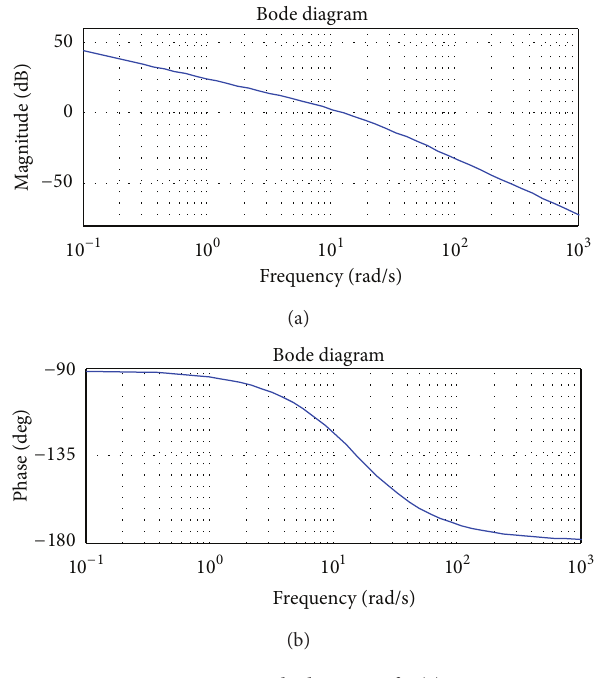
Figure 3: Bode diagram of 𝐺(𝑠)